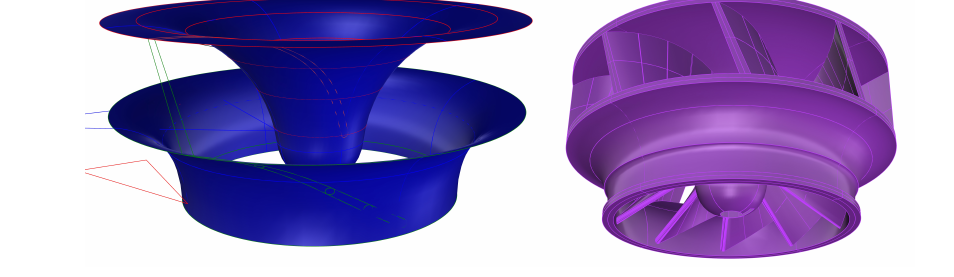
Figure 11. Impeller vanes’ drawing.